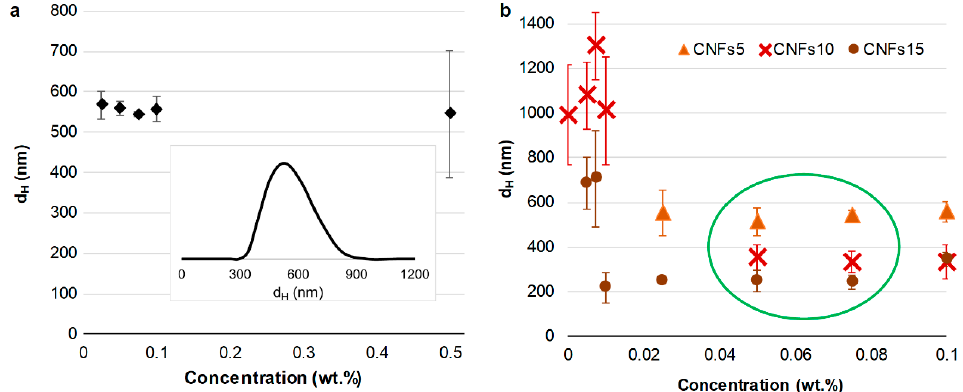
Figure 2. Intensity-weighted average hydrodynamic diameter of CNCs ( a ) and CNFs ( b ), as a function of concentration. The amplitude of the error bars is twice the standard deviation. Inset of ( a ) is the general shape of the size distribution (0.075 wt